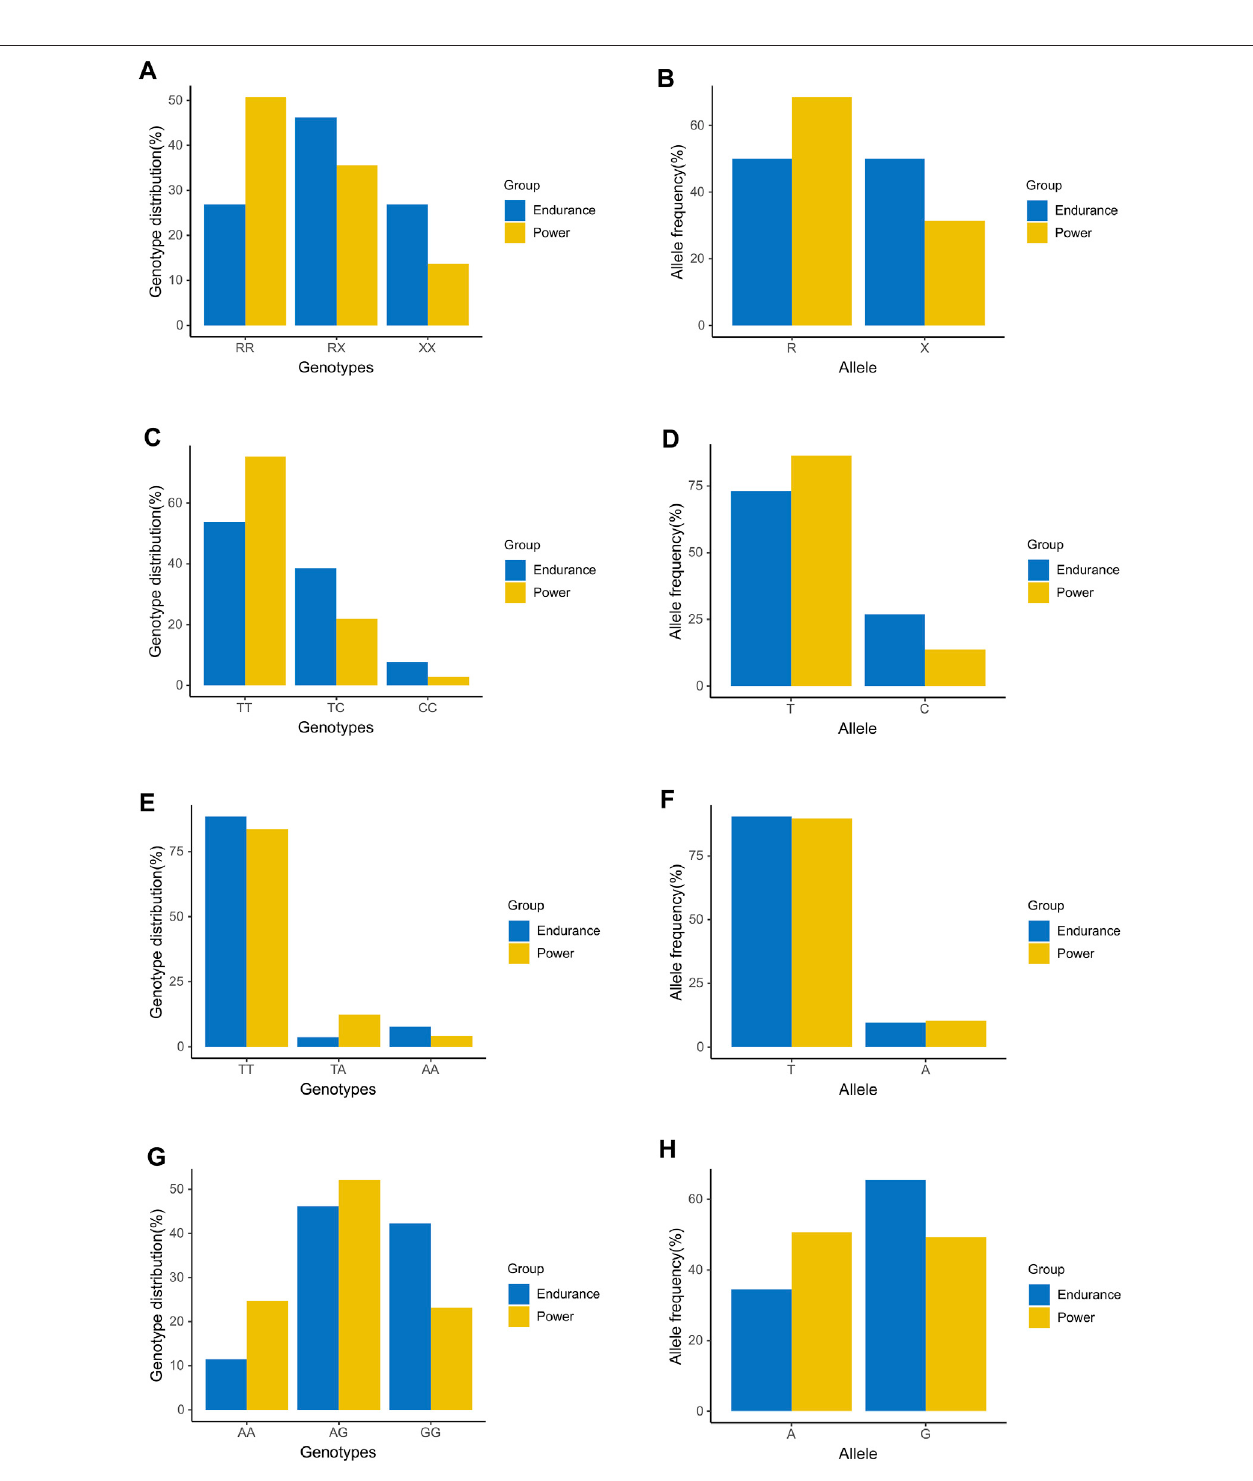
FIGURE 1 | Comparison analysis of genotype distribution and allele frequencies between additional power and endurance athletes in candidate SNPs for validation. (A) Genotype distribution of ACTN3 (rs1815739). (B) Allele frequency of ACTN3 (rs1815739). (C) Genotype distribution of ADRB3 (rs4994). (D) Allele frequency of ADRB3 (rs4994). (E) Genotype distribution of CNTFR (rs2070802). (F) Allele frequency of CNTFR (rs2070802). (G) Genotype distribution of PPARGC1A (rs8192678). (H) Allele frequency of PPARGC1A (rs8192678).